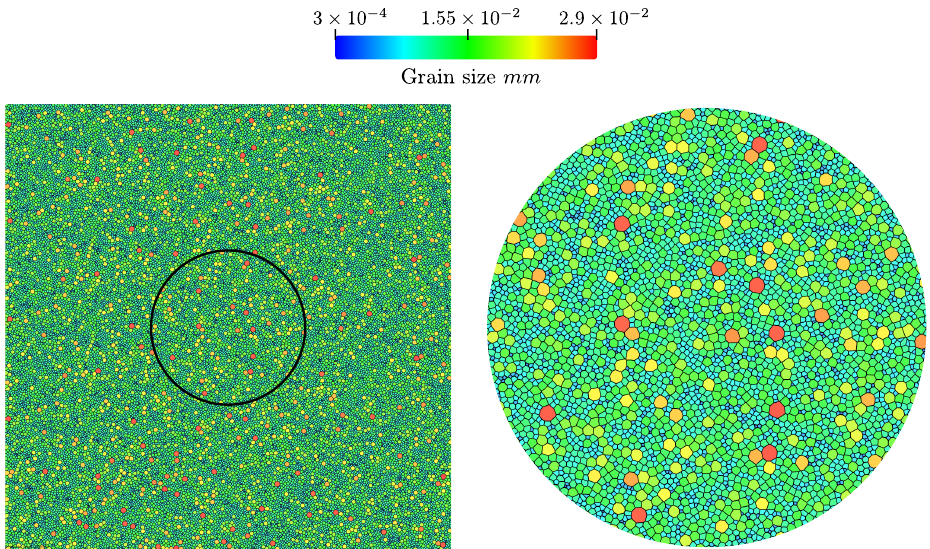
Figure 8. Example of the initial state of a 2D heterogeneous GG test case with 40,000 initial grains, ( left ) grain size field, ( right ) zoom of the circular